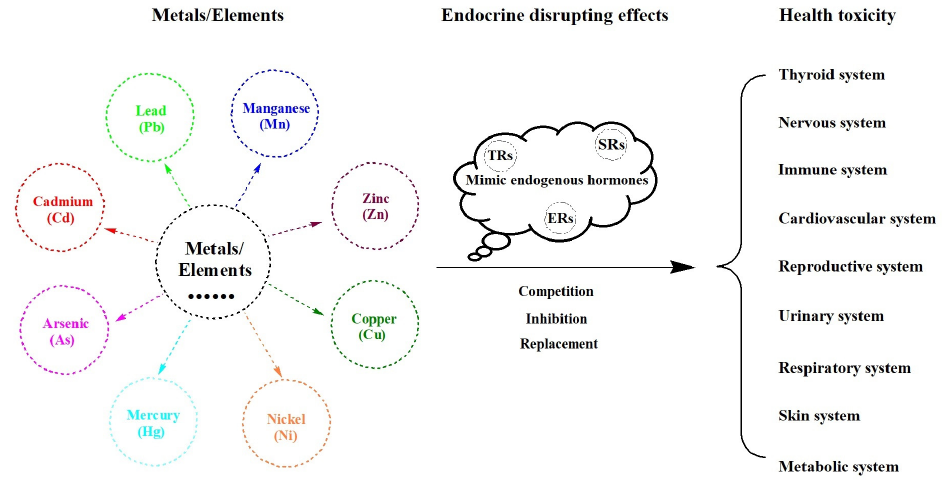
Figure 1. Endocrine-disrupting effects of heavy metals on health.